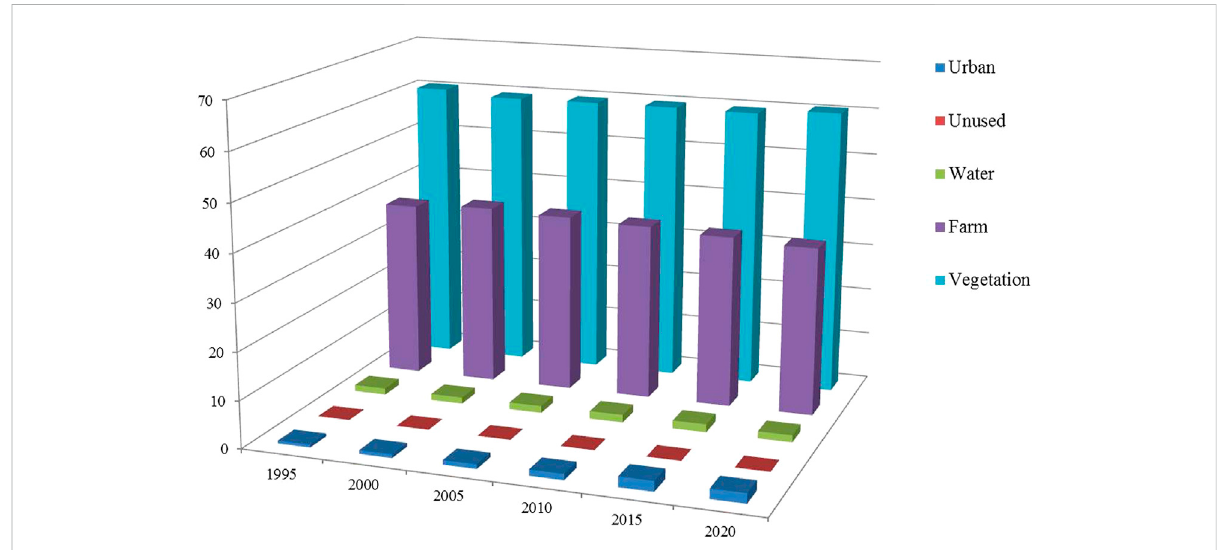
FIGURE 2 Land use/land cover changes from 1985 to 2020 in the TGR